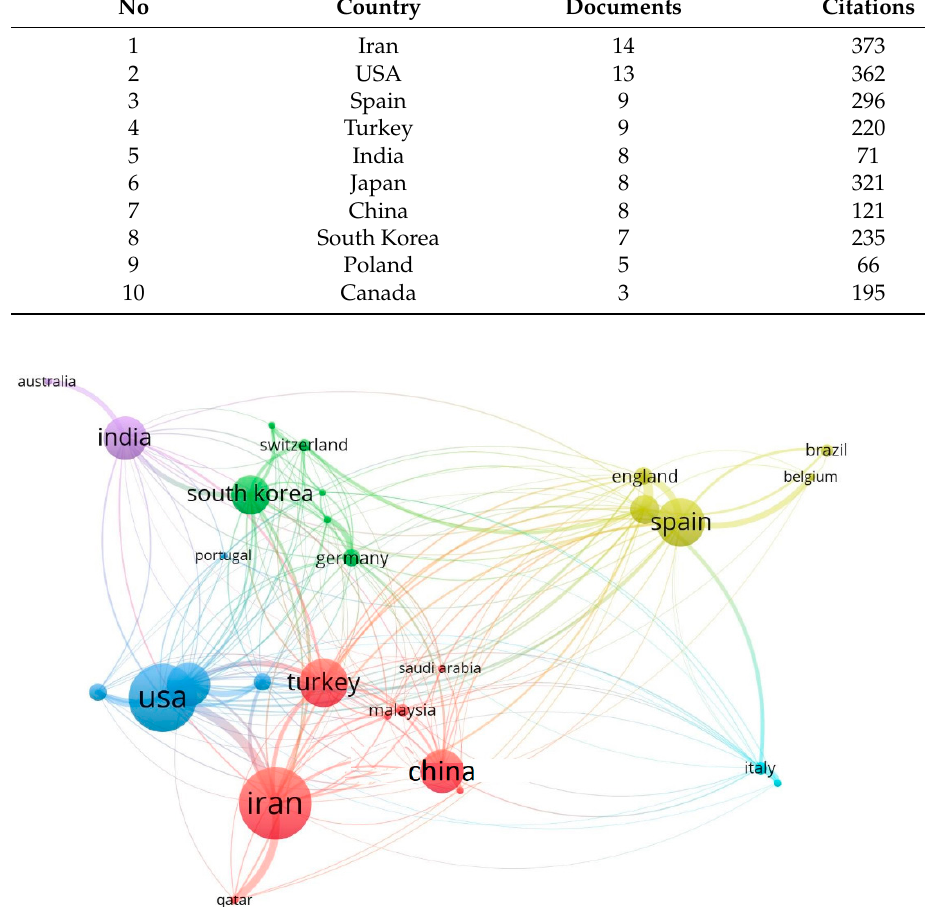
Figure 4. Publications related to nanocomposites.